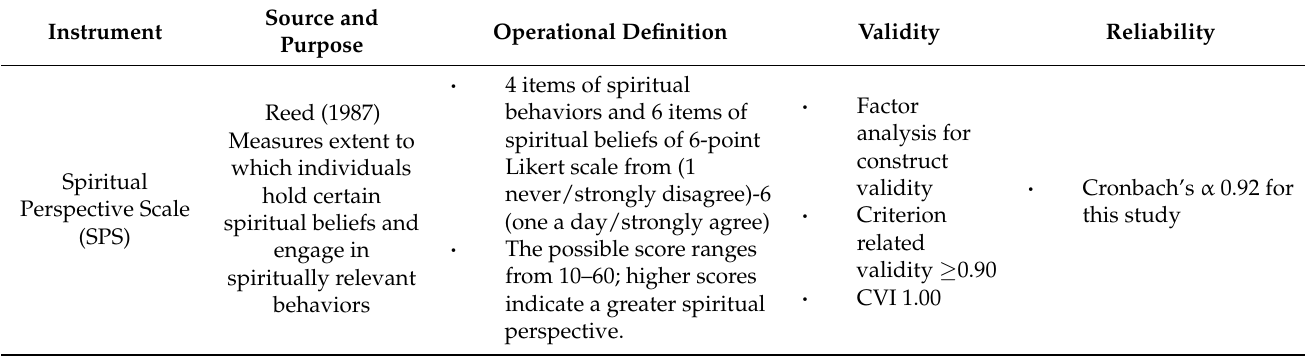
Table A1. Instrument developers, operational definition, validity, and